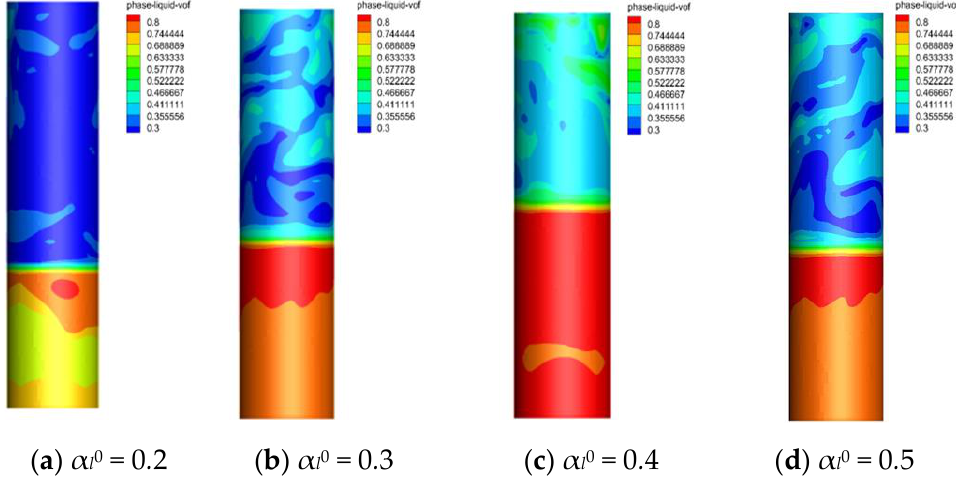
Figure 13. Distribution of the liquid volume fraction at t = 50 s, α l 0 = 0.2, 0.3, 0.4, and 0.5.